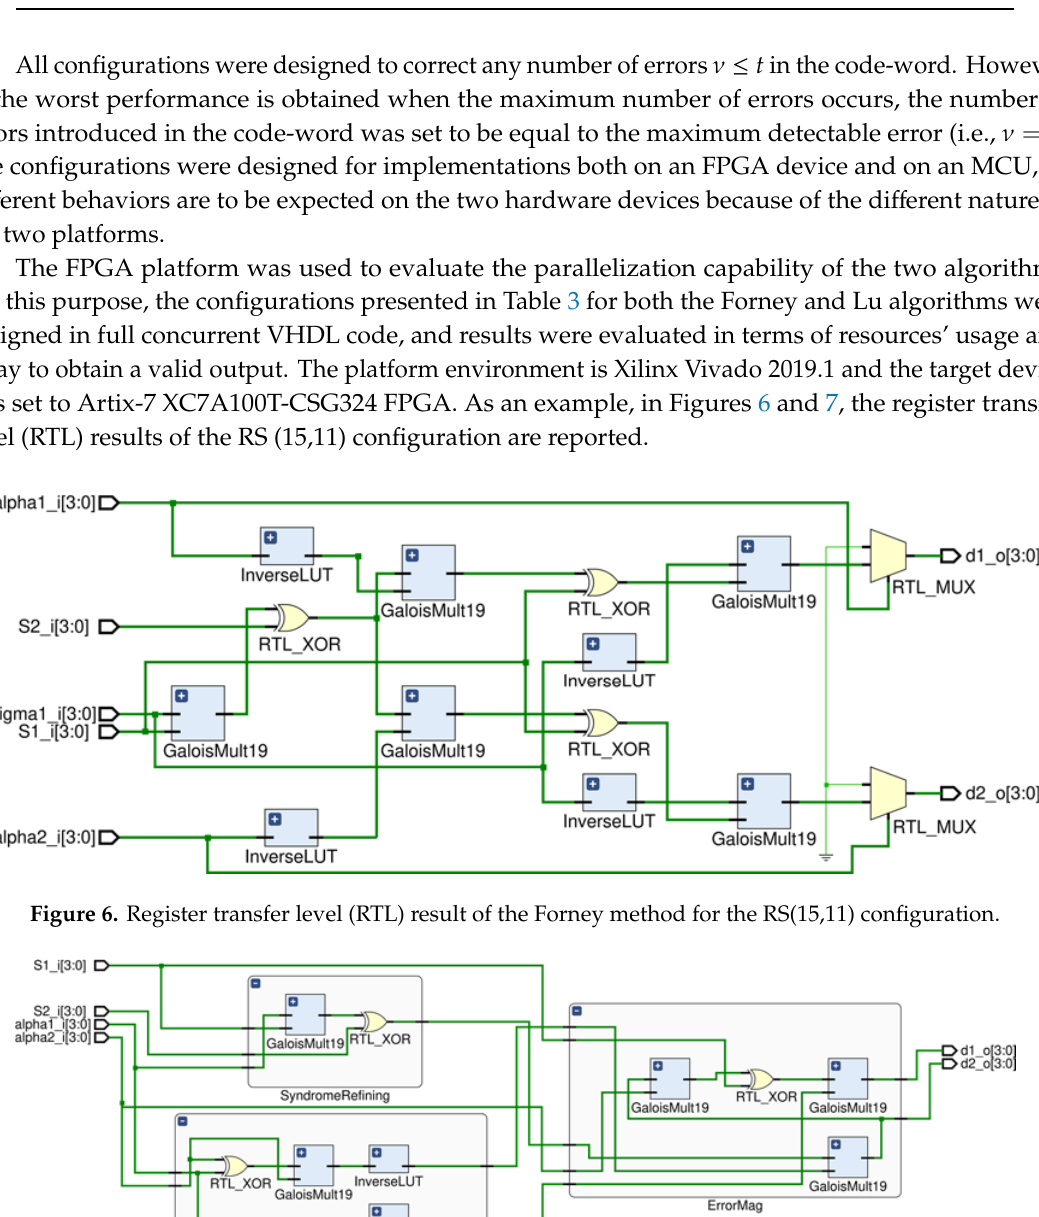
Table 3. Configurations designed for the implementation comparison.